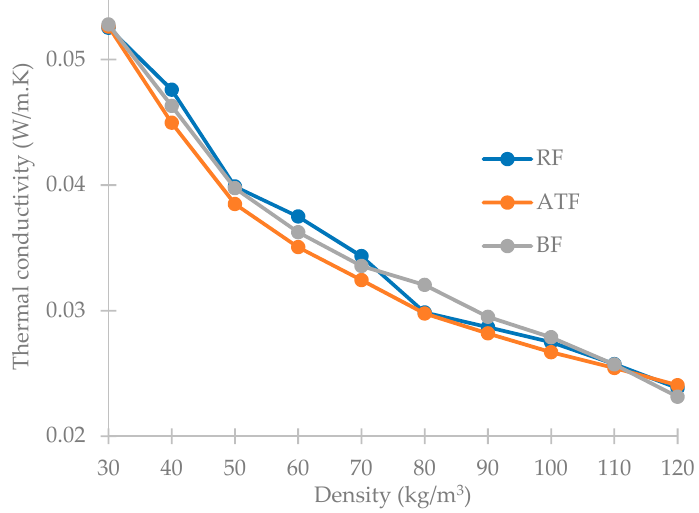
Figure 11. Relationship between thermal conductivity and density of coconut fibers.